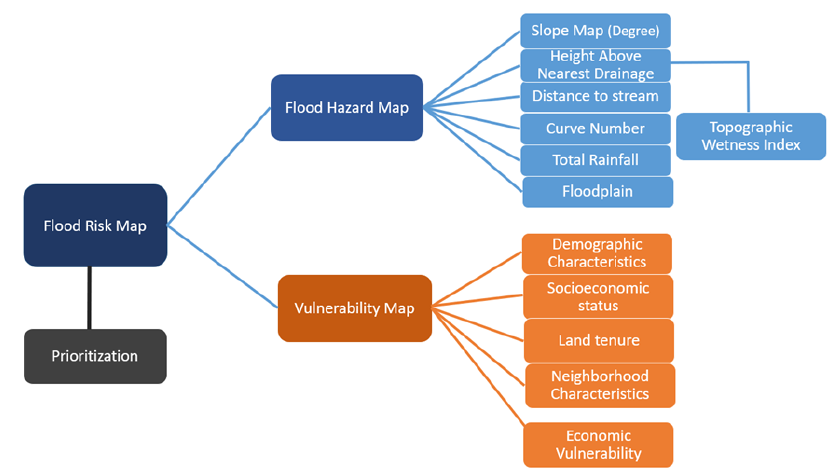
Figure 3. Flood risk prioritization schematization based on SMCE.